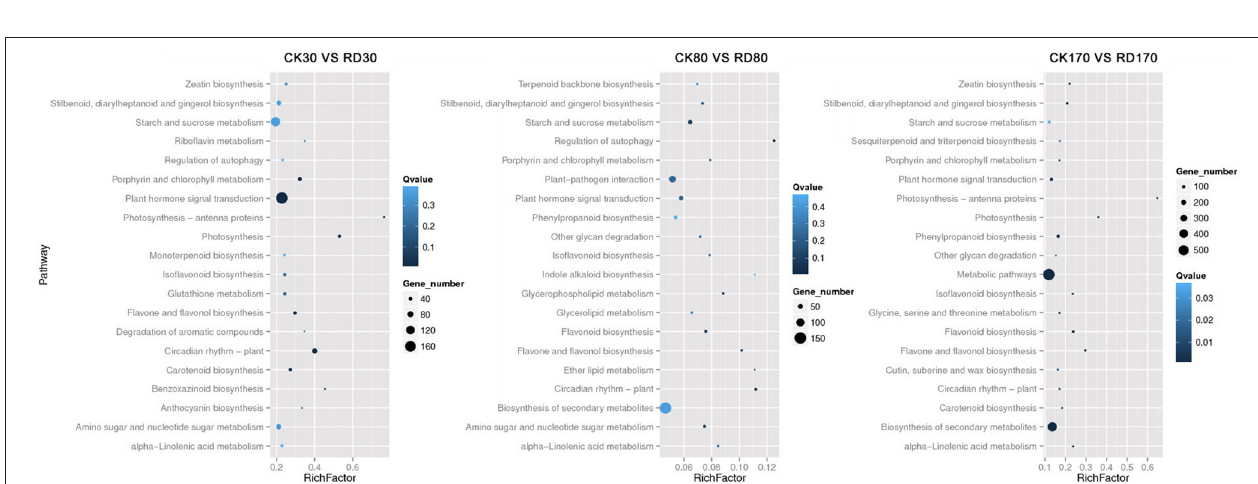
IAA, GA 3 , CTK, and mixture treatments except a slightly larger fruit in mixture treatment at 85 DAFB. Along with fruit enlargement, fruit peel thickness changed significantly depending on hormones ( Table 4 ). Compared to CK, thickened peel was found at 85 DAFB, a month after treating, and peel thickness was 3.56, 3.27, and 3.78 mm in IAA, GA 3 , and mixture treatments, respectively. CTK and CK treatments were thinner, < 2.9